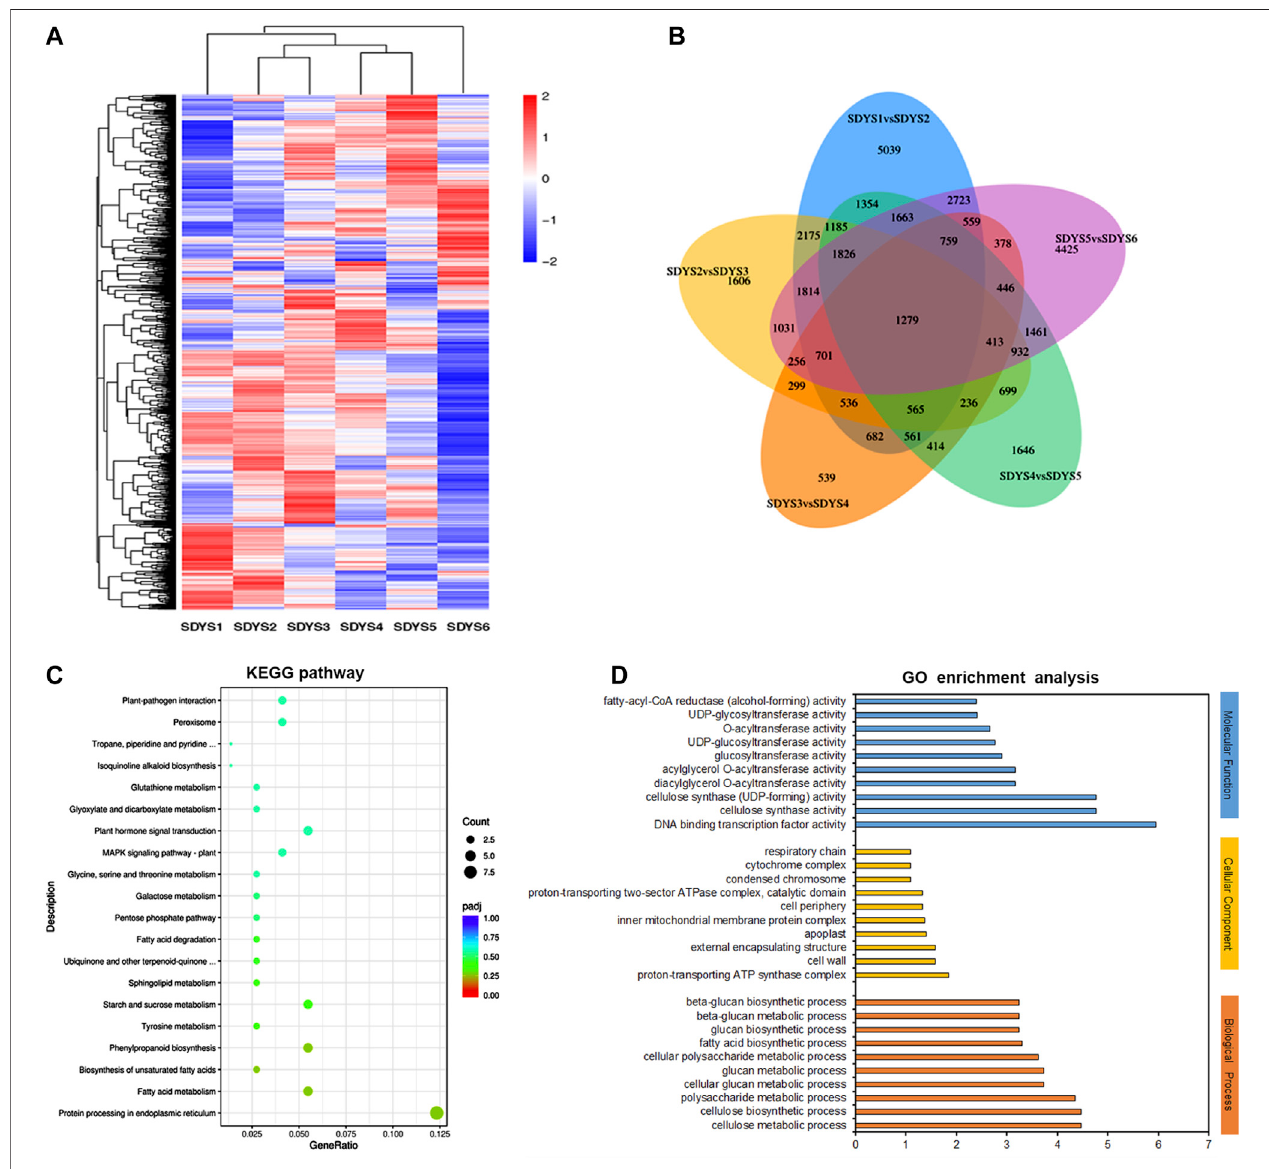
FIGURE 4 | Identi fi cation and analysis of differentially expressed genes during embryonic development stages. (A) Heat map, (B) Venn diagram, (C) KEGG annotation, and (D) GO enrichment analysis of differentially expressed genes in six embryonic development stages.